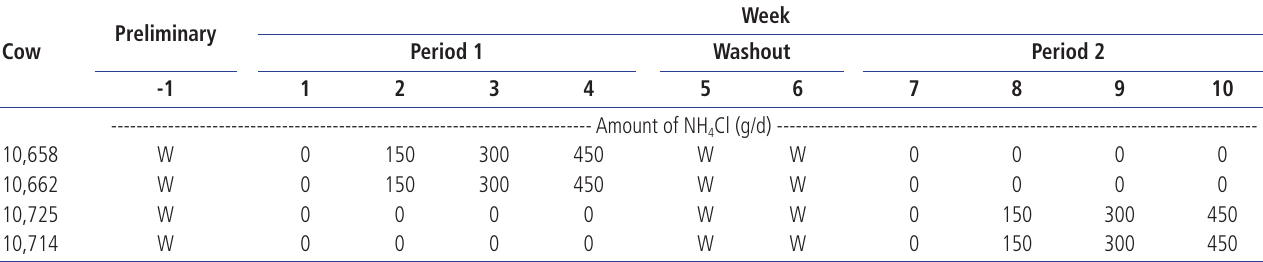
Table 2. Schematic of experimental design and application of treatments Cow